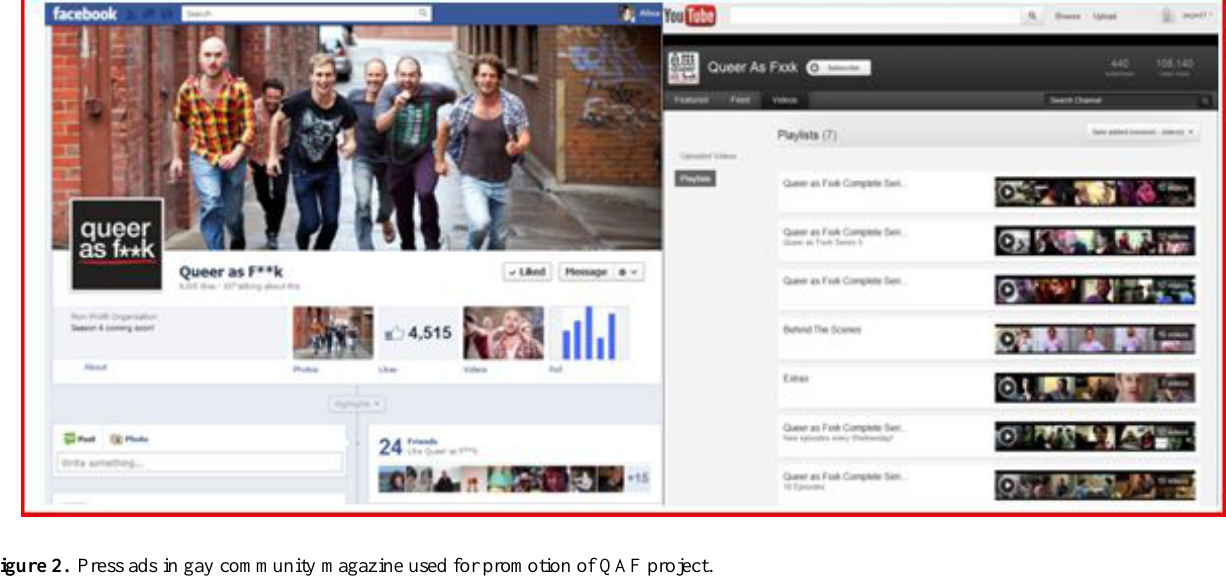
Figure 1. Screen shots of Facebook and YouTube.